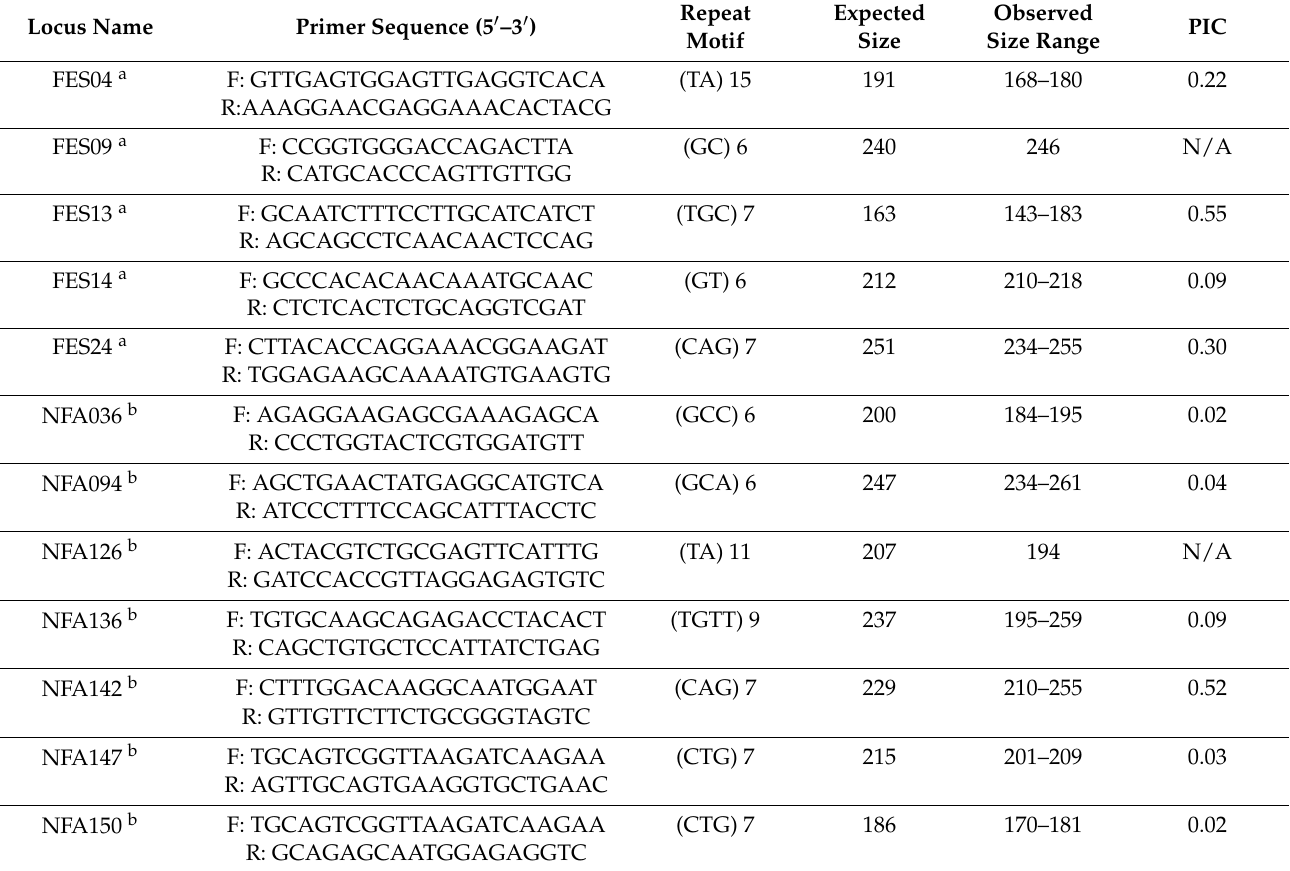
Table 1. Name and sequences of EST-SSR primer-pairs used in this study; repeat motifs, expected product size (bp), observed product size range (bp) and polymorphic information content (PIC) of their target